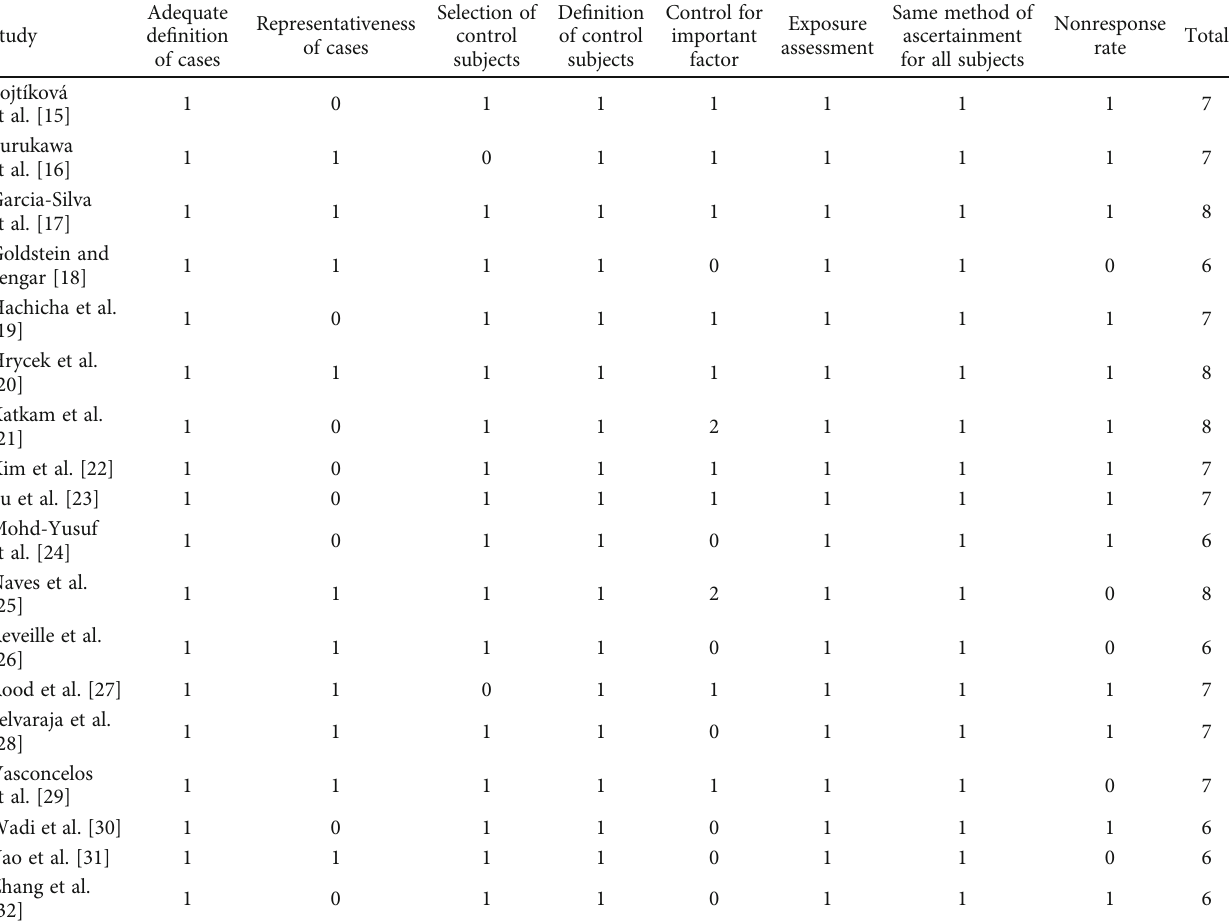
Table 2: Quality of included studies was assessed according to the Newcastle-Ottawa